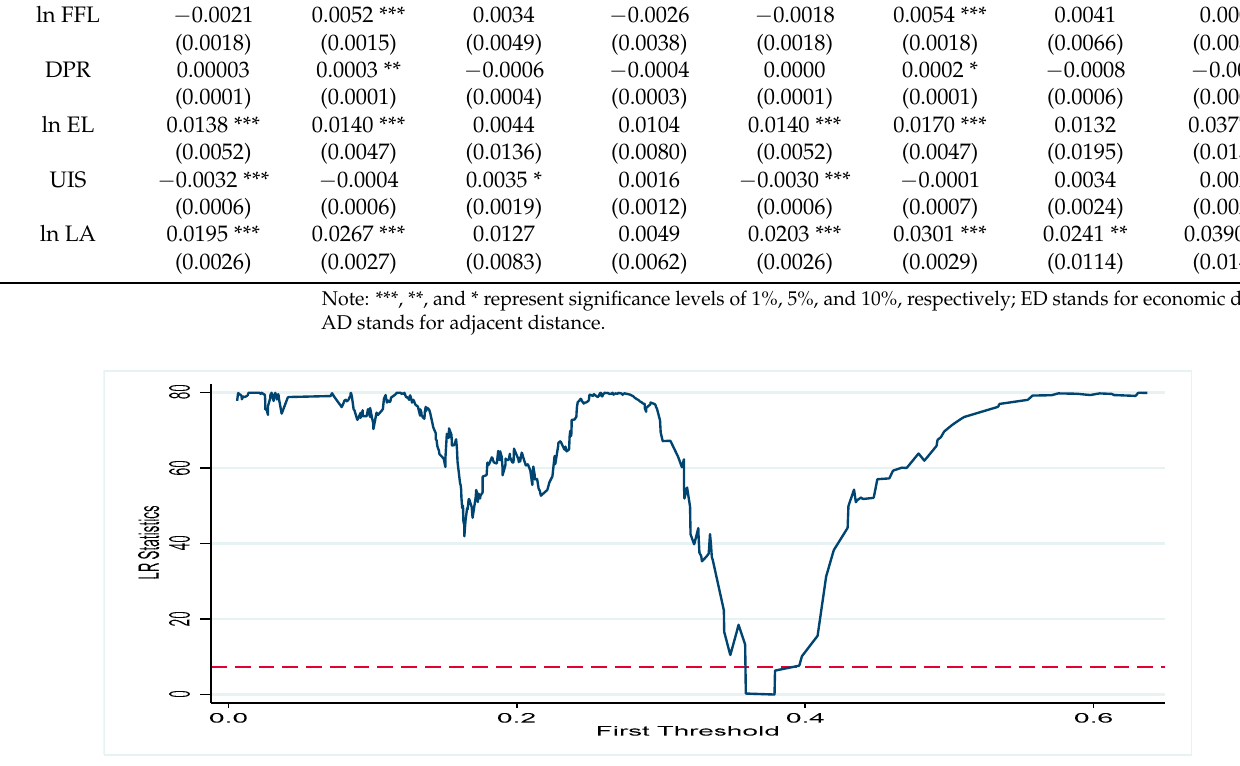
Figure 2. Threshold test based on FTI. Table 10. Threshold effect test results.